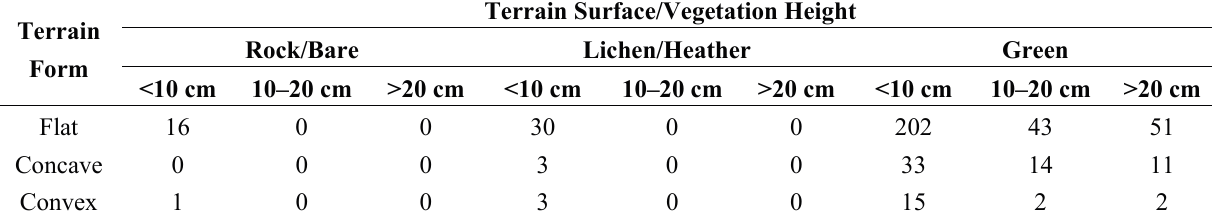
Table 1. Frequency distribution of the measured ground control points a on terrain form, terrain surface and vegetation height.